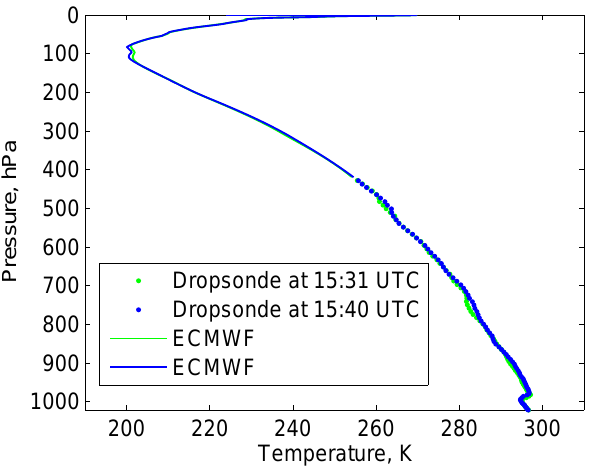
Fig. 6. The CO 2 mixing ratio profiles derived from the ECMWF analysis and time-space co-located with the 25 JAIVEx IASI sound-